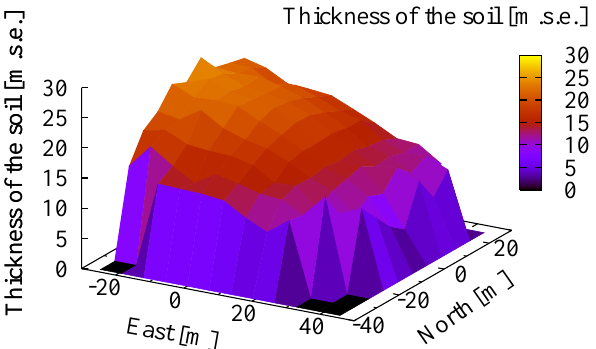
Fig. 4. The local map and the projection of the view angle of the J´ozsef Mountain above the Moln´ar Ja´nos Cave. The detector was placed at the origo within the West-East orientational artificial cav- ern. Dashedbluelines are for the whole view angle of the Muon- tomograph, while solidblacklines shows the region useable for the relief reconstruction. Redcontours show the thickness of the mate- rial in meter-soil-equivalent (m. s. e.).